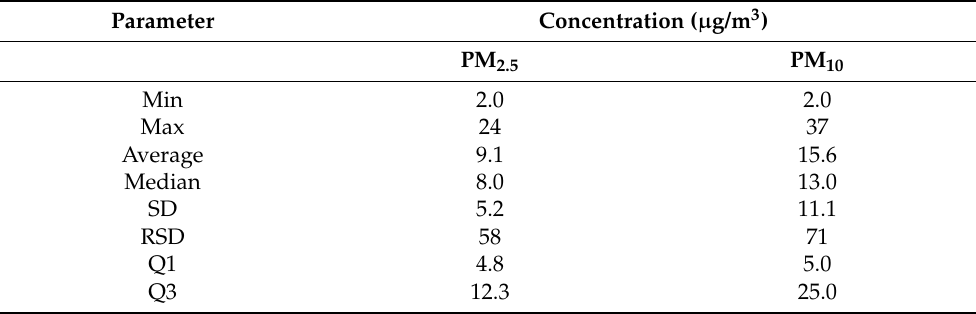
Table 7. Statistics of hourly air monitoring data recorded by an official air quality station (Gilice Square, Budapest) between 15 and 18 April